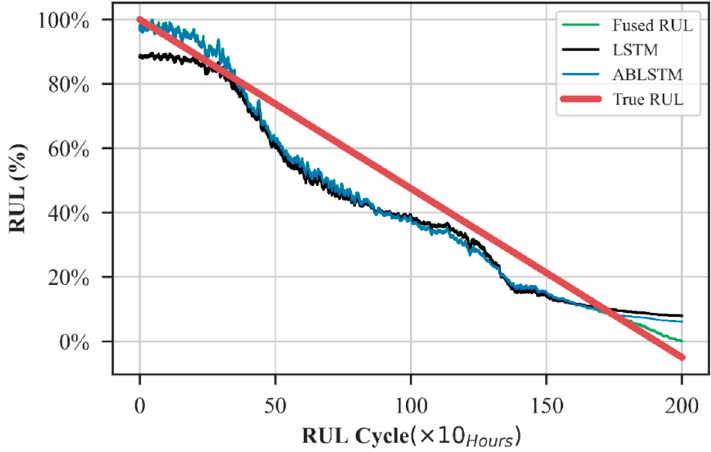
Figure 14. Prediction result of BiLSTM model on hybrid fault dataset. Table 5. Model Parameters used for RUL Prediction.